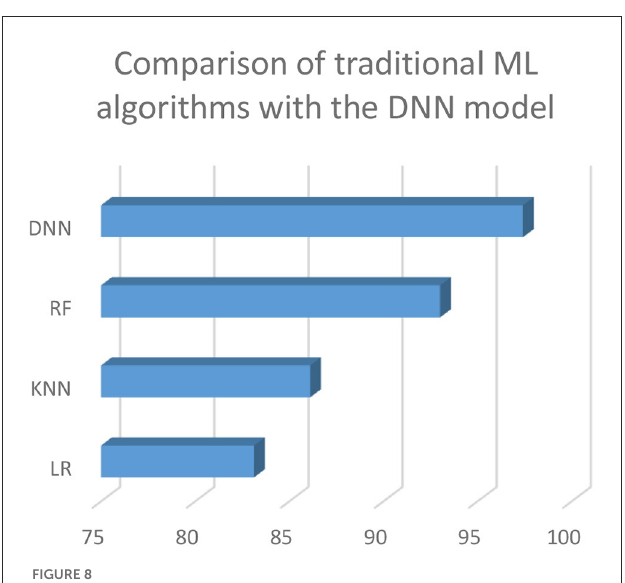
FIGURE8 Comparison with the traditional ML